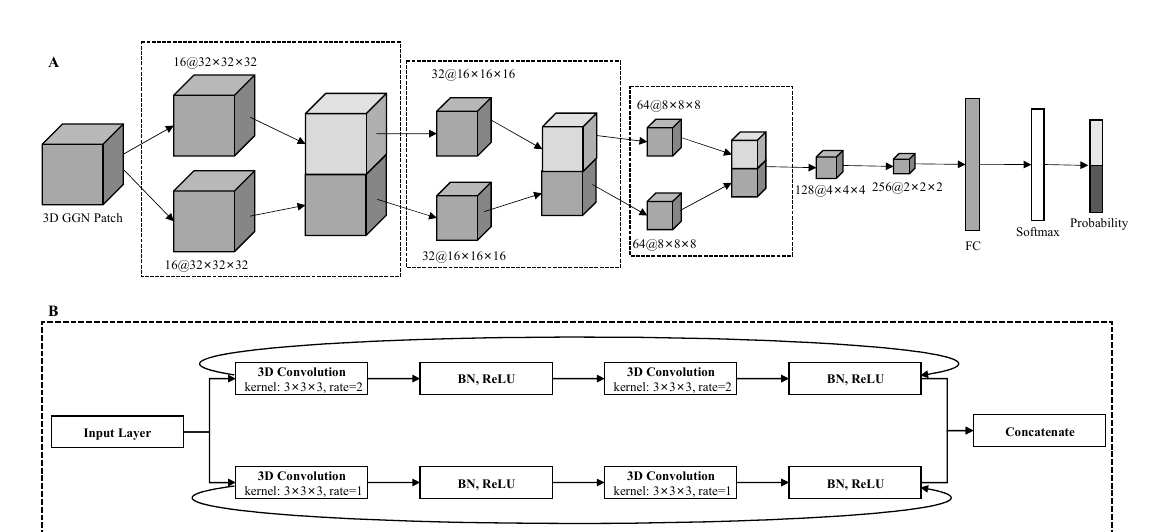
Figure A2. The architecture of the proposed 3D CNN-based DNN model. ( A ) the architecture of 3D ResNet to build the classification models for two tasks. ( B ) the architecture of multi-level concatenated atrous pyramid convolution module showed in the black dotted bordered rectangle of ( A